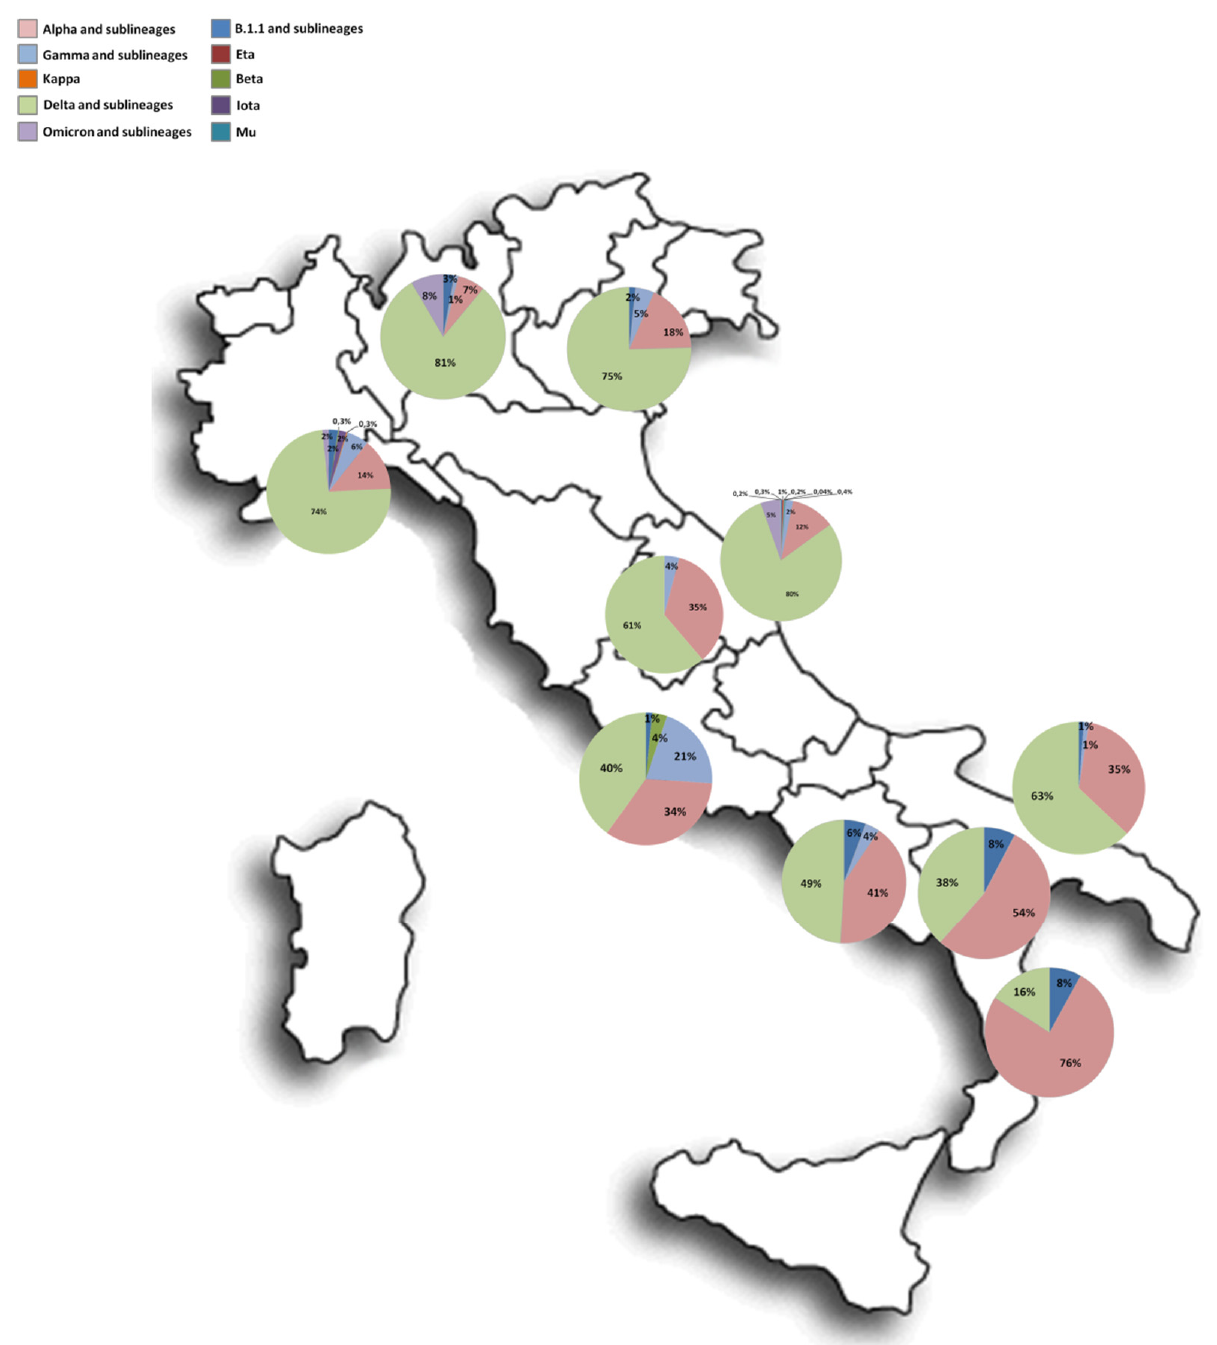
Figure 2. Spatial distribution of lineages in different regions.